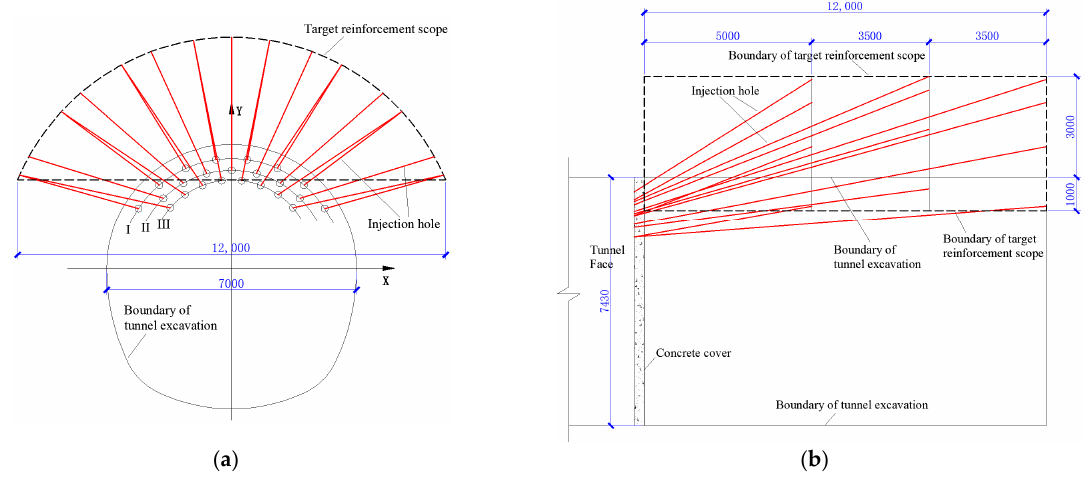
Figure 16. Design of injection holes (unit: mm). ( a ) Cross section. ( b ) Longitudinal section. Calculation results of macroscopic performance parameters of the sand layer before